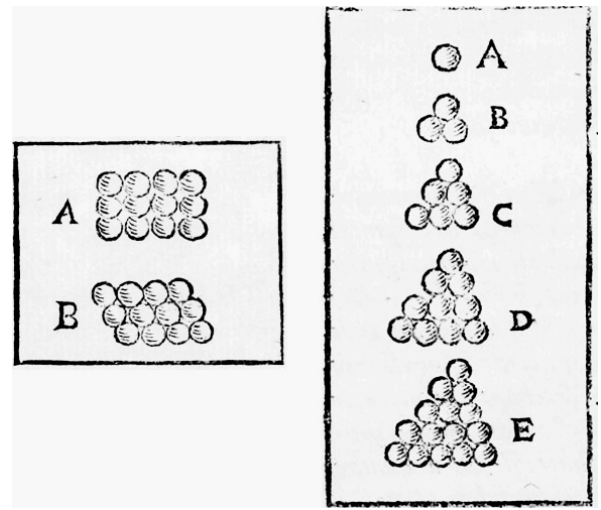
Figure 1. Close packing of spheres described by J. Kepler. (From reference 4, pp.